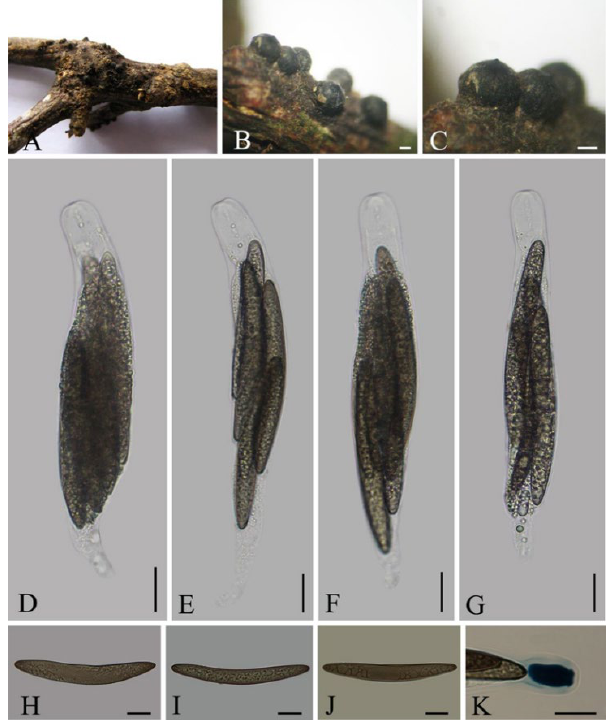
Figure 7. Rosellinia vitis (GZUH0123). ( A ‒ C ) Stromata on the host; ( D ‒ G ) Asci ( H ‒ J ) Ascospores; ( K ) Urn-shaped J+ apical ring (stained in Melzer’s reagent). Bars: ( B , C ) = 200 μm, ( D ‒ J ) = 20 μm, ( K ) = 10 μm.